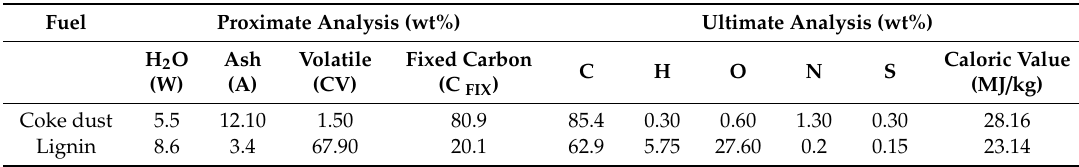
Table 1. Chemical analysis and energy content of fuels [12].